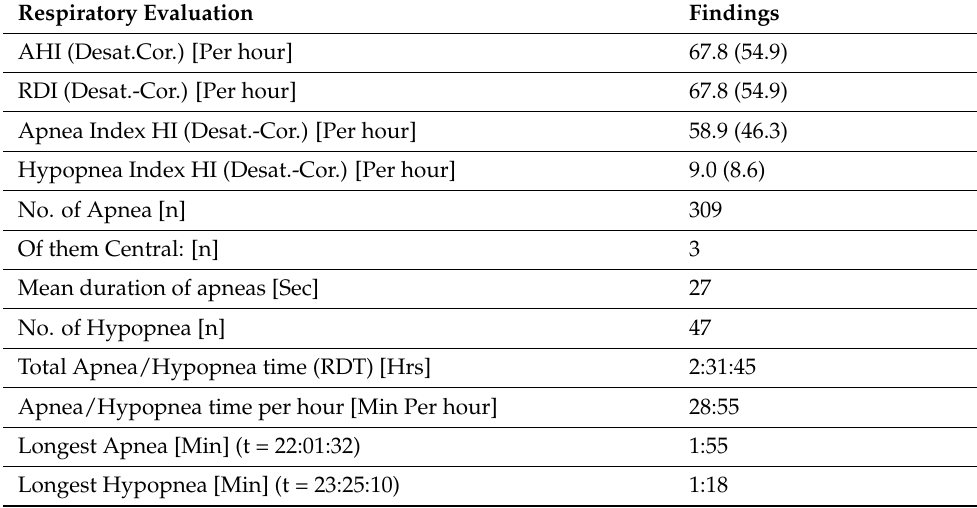
Figure 2. CT scan of the head and paranasal sinuses showing tumor extension in the ( A ) nasal cavity, nasopharynx, and contralateral choana, ( B ) maxillary sinus, ( C ) sphenoidal sinus. A polysomnographic study showed severe obstructive sleep apnea syndrome (AHI = 67.8) with the most prolonged apnea episode duration of 1 min and 55 s (Table 1). Most episodes were represented by obstructive apneas (oA = 73%), while central and mixed apneas represented 1% and 12%, respectively. The rest of the 13% were hypopneas (Chart 1). Table 1. Polysomnographic respiratory parameters at presentation.